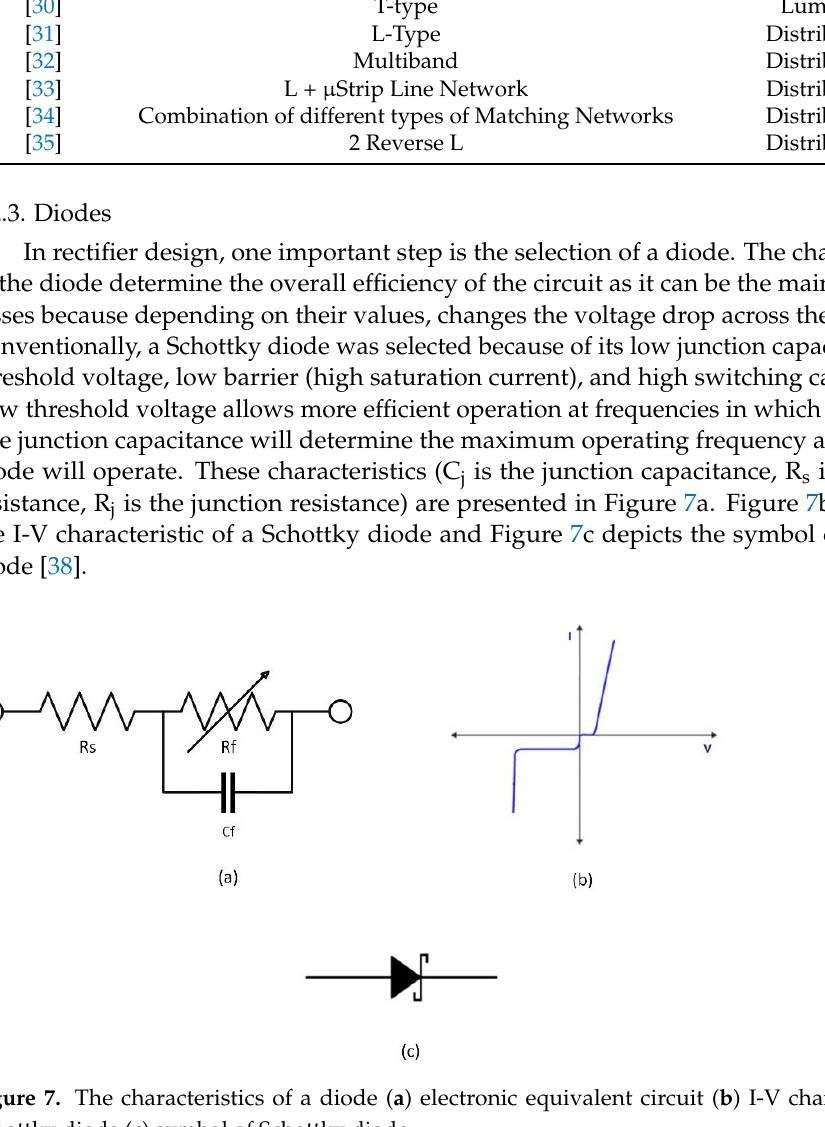
Table 3. Schottky diodes.